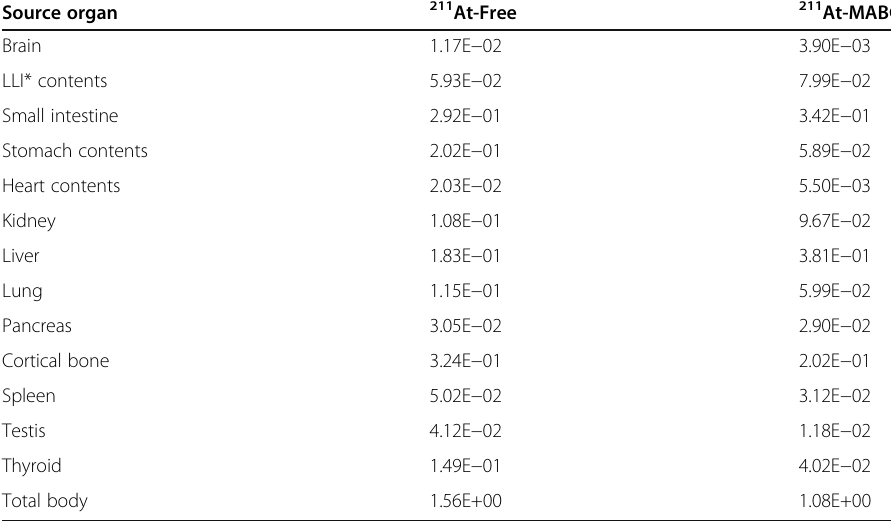
Table 1 Time-integrated activity coefficient (Bq-h/Bq) for 25 g mouse model calculated using OLINDA/EXM version 1.1 for free 211 At and 211 At-MABG in the main target organs. Data are based